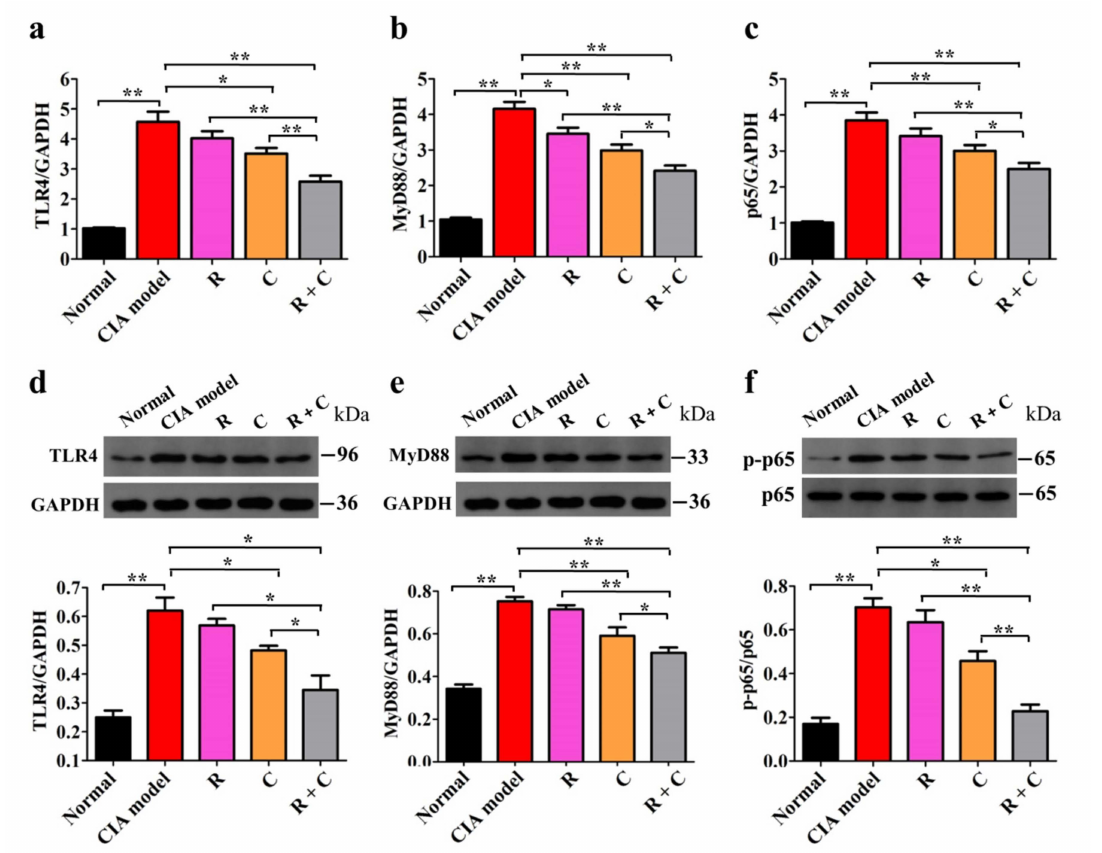
Figure 6. Rosmanol (R), carnosol (C), and their combination (R + C) inhibited the TLR4/NF- κ B pathway. The relative transcription levels of TLR4 ( a ), MyD88 ( b ), and NF- κ B p65 ( c ) in synovial tissue samples of each group were quantified by real-time PCR on day 42. The representative Western blot analysis results and protein relative expression levels for TLR4 ( d ), MyD88 ( e ), and NF- κ B p-p65 ( f ) in synovial tissue samples of each group on day 42 are shown. GAPDH was used as an internal reference to quantify the expression levels of TLR4 and MyD88. The phosphorylation of p65 was expressed as p-p65/p65. Data are presented as the mean ± SD ( n = 3). The significance of differences was analyzed by unpaired t -test. Note: *, p < 0.05; **, p <